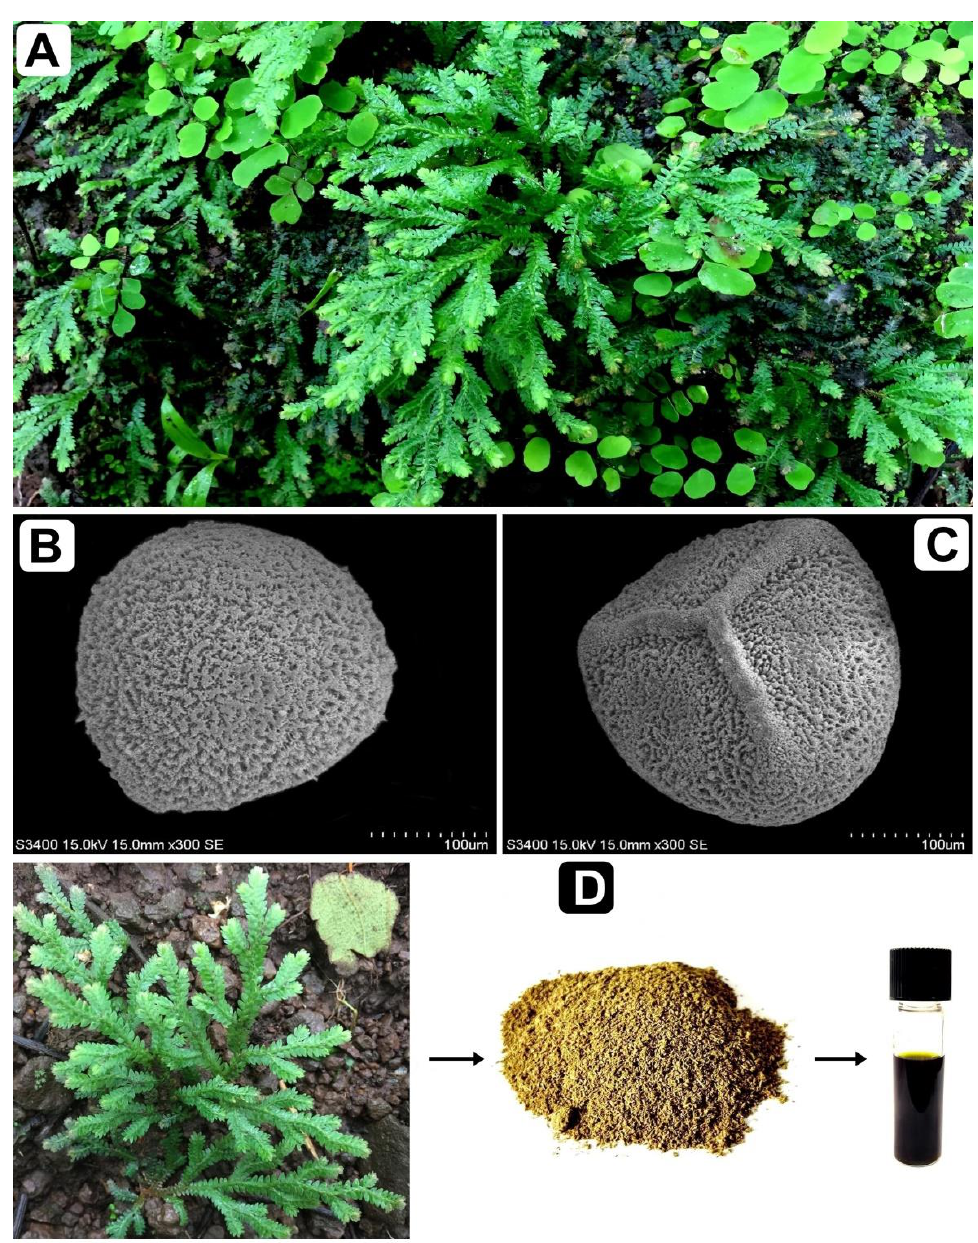
Figure 9. S. repanda plant: ( A ) in the wild, ( B , C ) the structure of spores under scanning electron microscope (SEM) and ( D ) preparation of the crude extract.